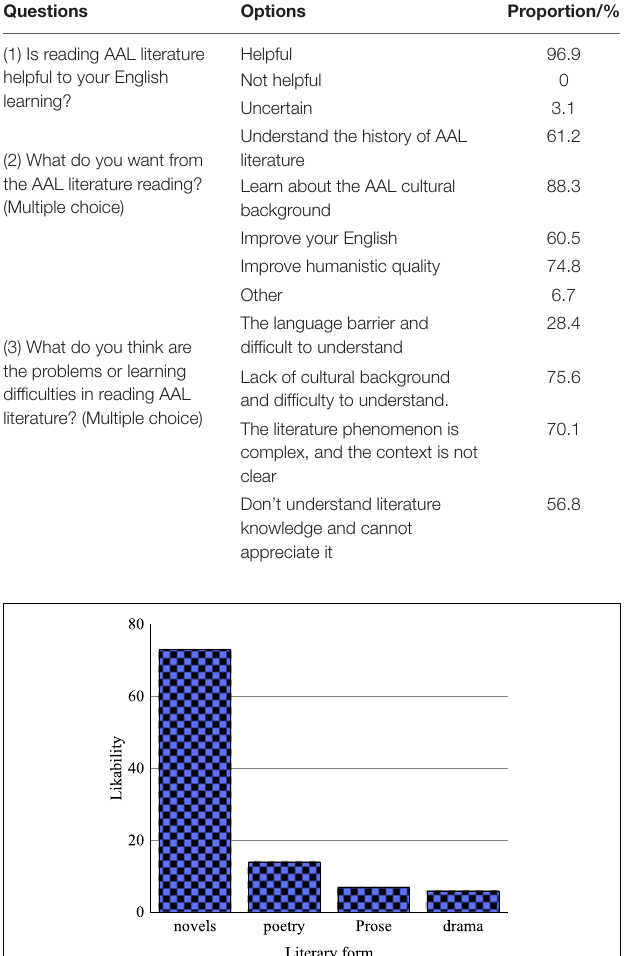
FIGURE 10 | A statistical chart of the results of the pre-survey on the popularity of different forms of AAL literature.